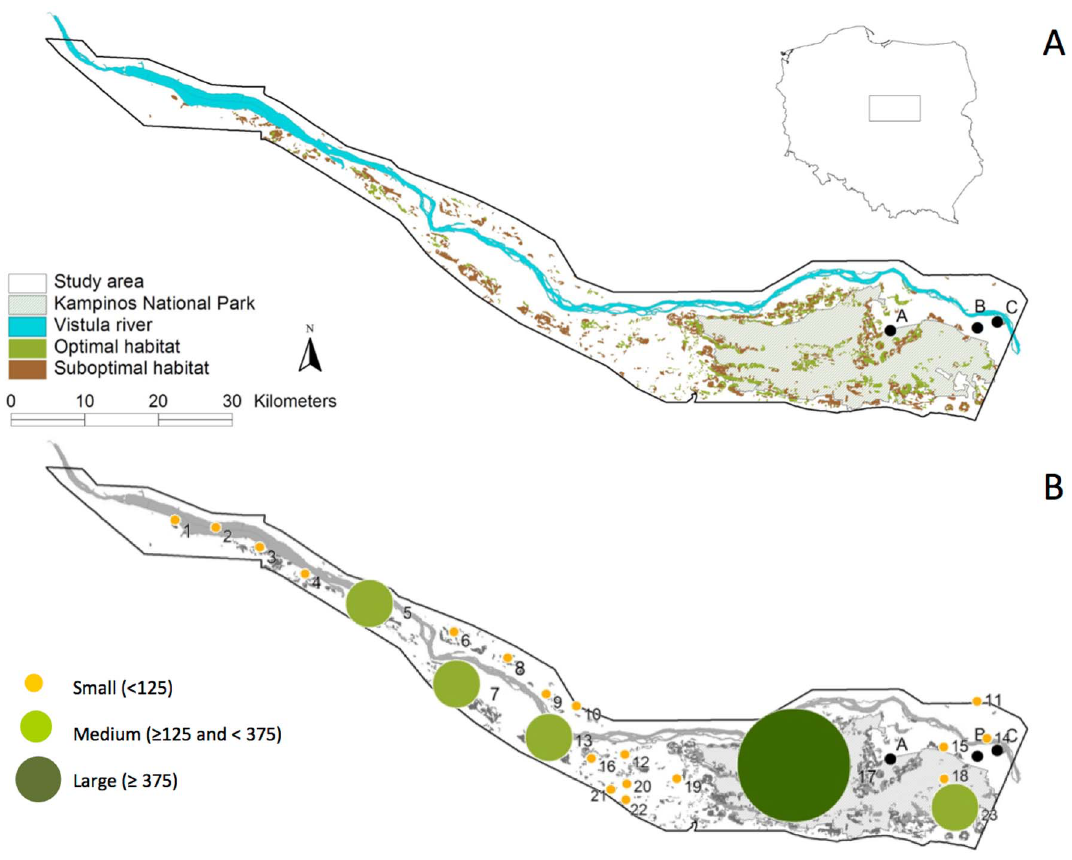
Figure 1. Study area and metapopulation structure. (A) Study area of the Vistula river valley in central Poland. Optimal habitat for the natterjack toad is marked green and suboptimal habitat is marked brown. Location of the study plots is marked: A – ‘‘Brzozo´wka’’, B – ‘‘Sadowa’’, C – Ke˛pa Kiełpin´ska’’. (B) Metapopulation structure for no change scenario. Sizes and colours of circles indicate sizes of populations (numbers of individuals).